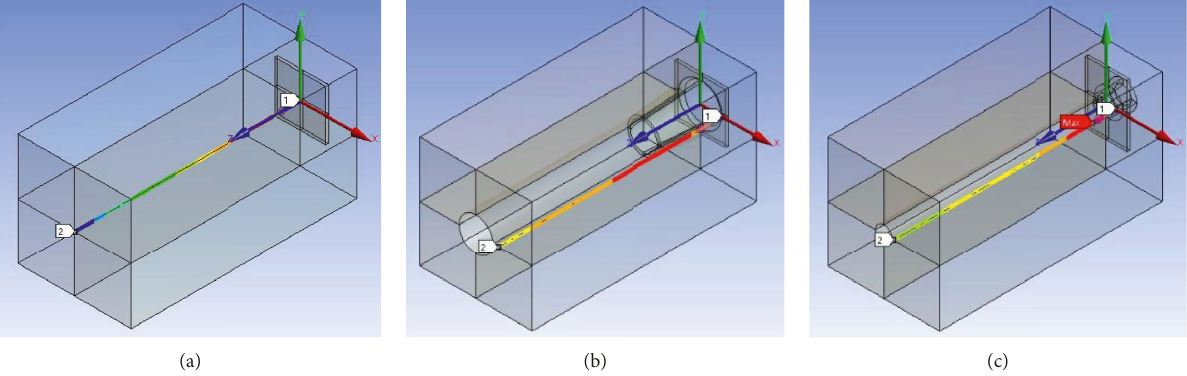
Figure 5: Virtual path across the tendon. (a) Model S, (b) Model C, and (c) Model